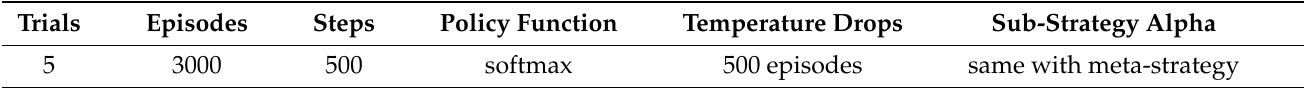
Table 1. Hyperparameters of experimental